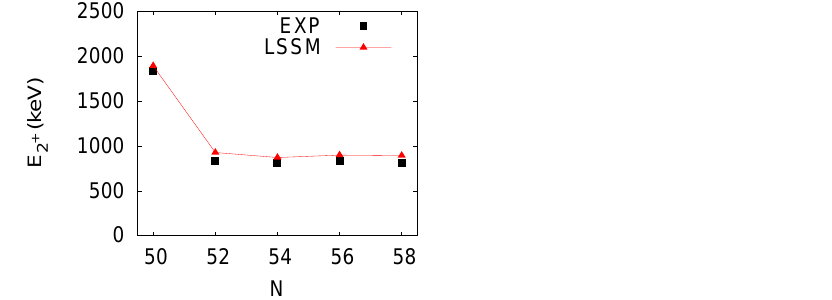
Figure 11. 2 + excitation energy along the Sr chain: experiment vs. present calculations.